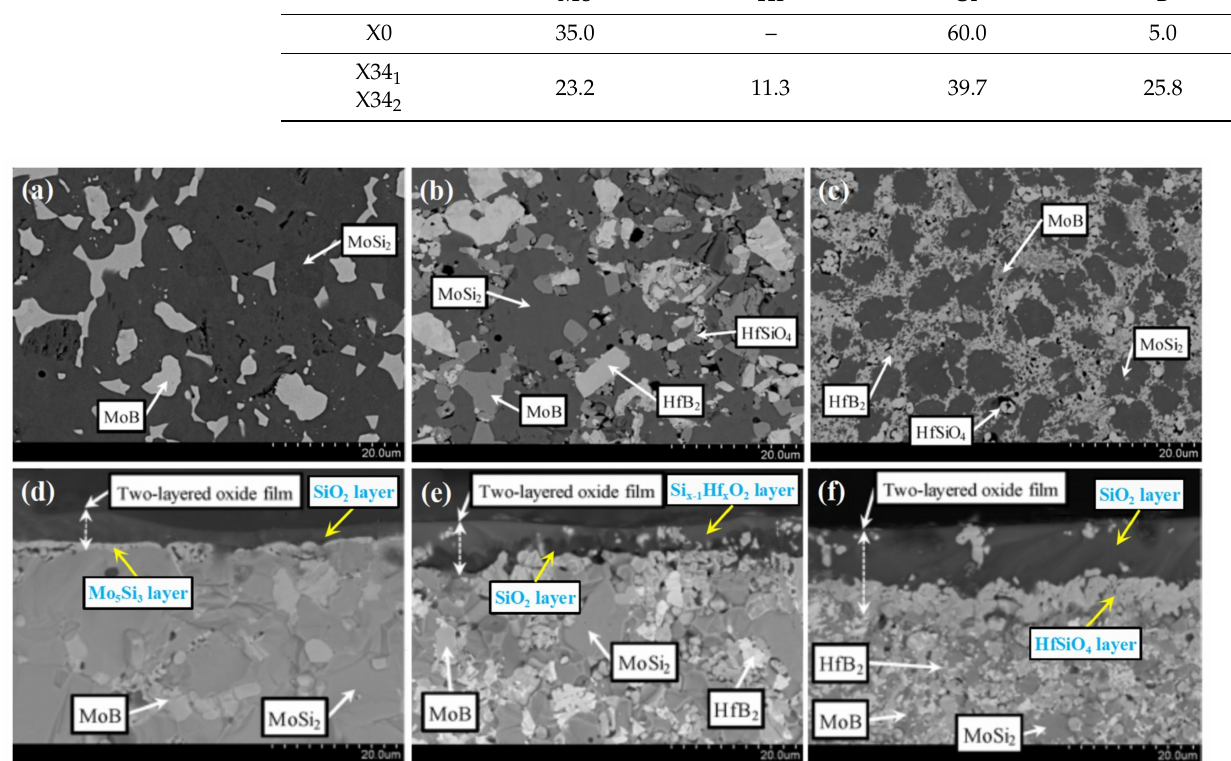
Figure 3. Microstructure of various samples: ( a ) X0, ( b ) X34 1 and ( c ) X34 2 ; cross-sectional SEM images of samples after oxidation at 1200 ◦ C for 30 h: ( d ) X0, ( e ) X34 1 and ( f ) X34 2 . Reproduced with permission [96]. Copyright 2019